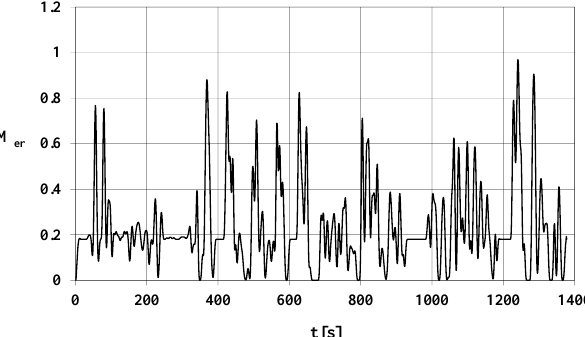
Fig. 5. The process of relative engine torque in the Malta test